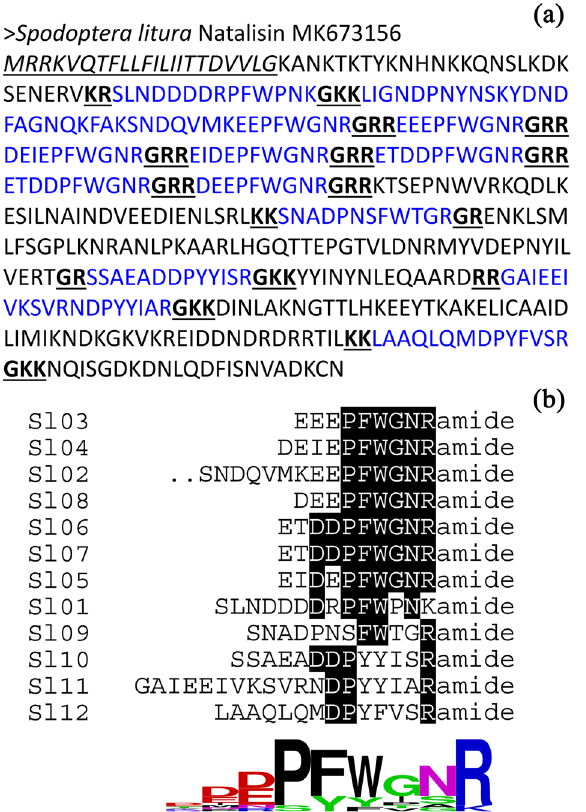
Figure 1. Deduced amino acid sequences of NTL precursors ( a ) and prediction of mature peptides ( b ). The putative signal peptide at the N terminus is in italics and underlined. Canonical amidation with di-basic signals is marked by bold and underlined fonts. The putative mature peptides were marked by blue fonts. The calculated consensus logo is shown at the